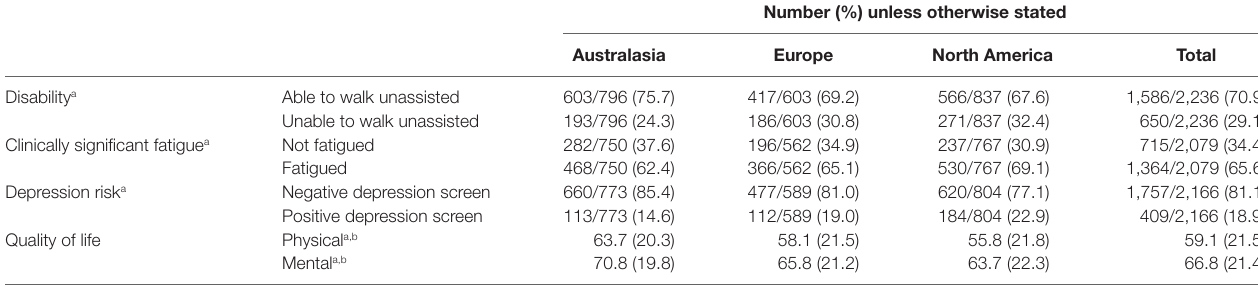
Table 2 | Health outcomes by